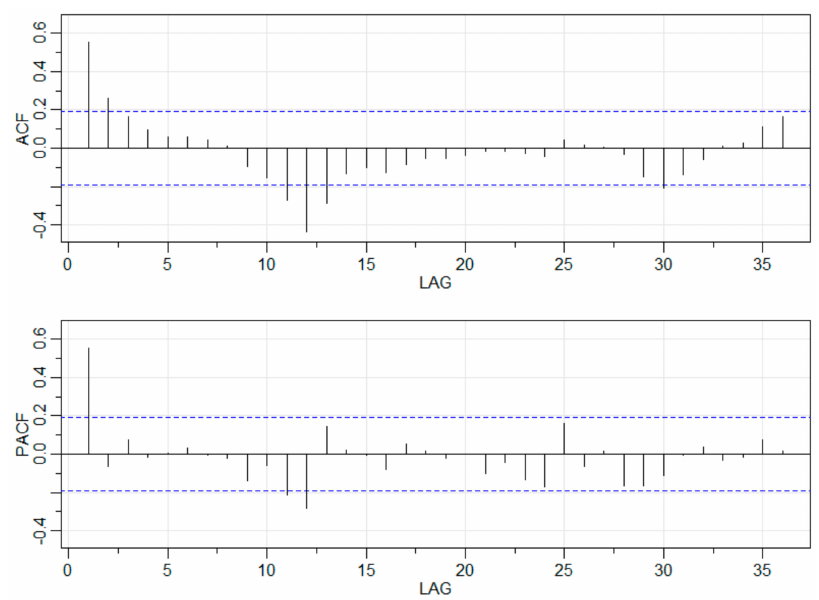
Figure 8. The ACF and PACF for transformed streamflow data showing auto and partial correlation for di ff erent lag months.